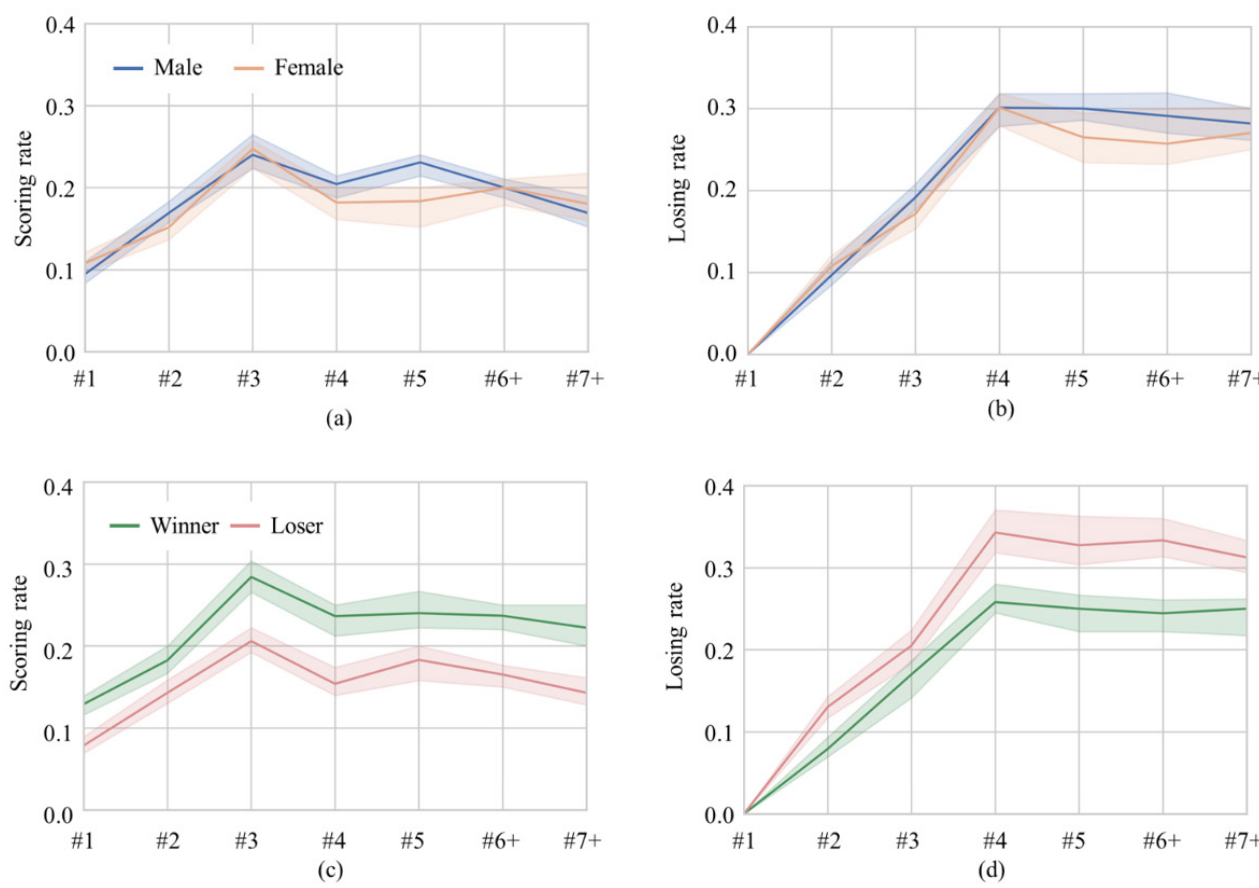
Figure 1. Scoring rate and losing rate at each shot number. The median of scoring rate and losing rate was calculated for each gender, winners, and losers. The shaded area denotes the 95% confidence interval.